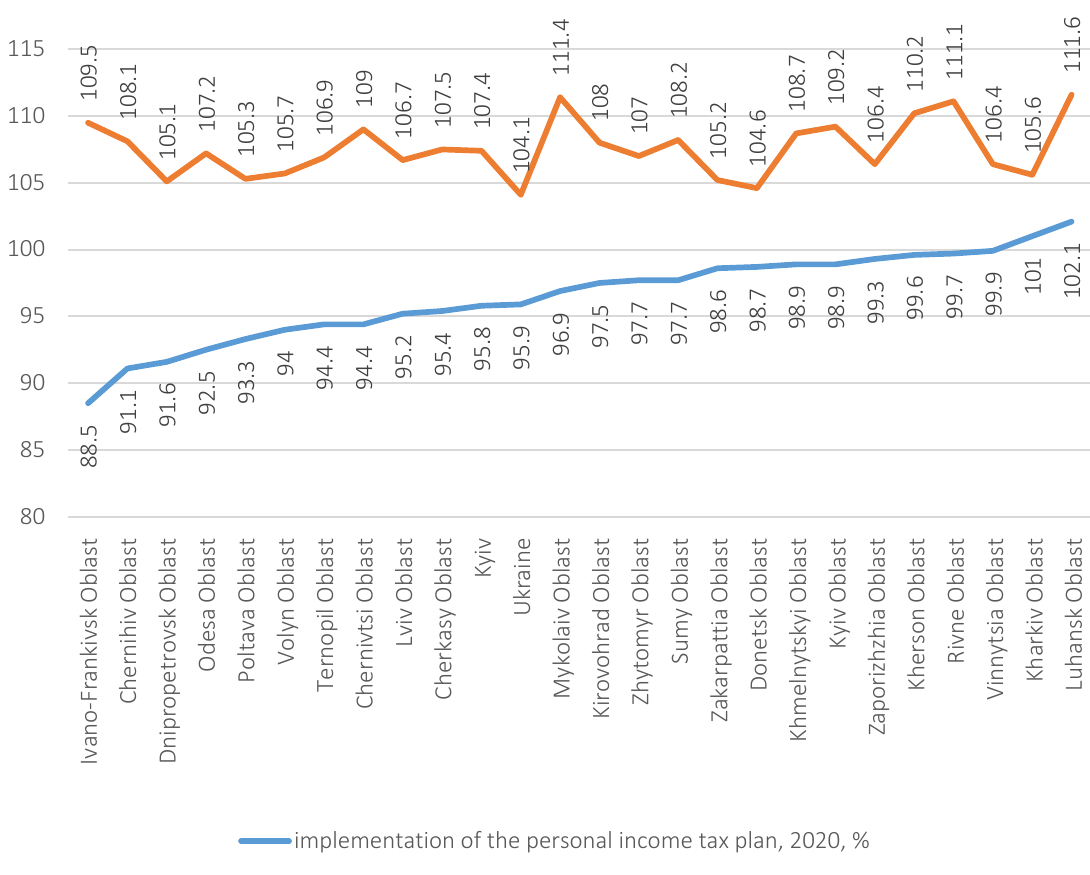
Figure 6. Local budgets’ revenues from personal income tax across regions,